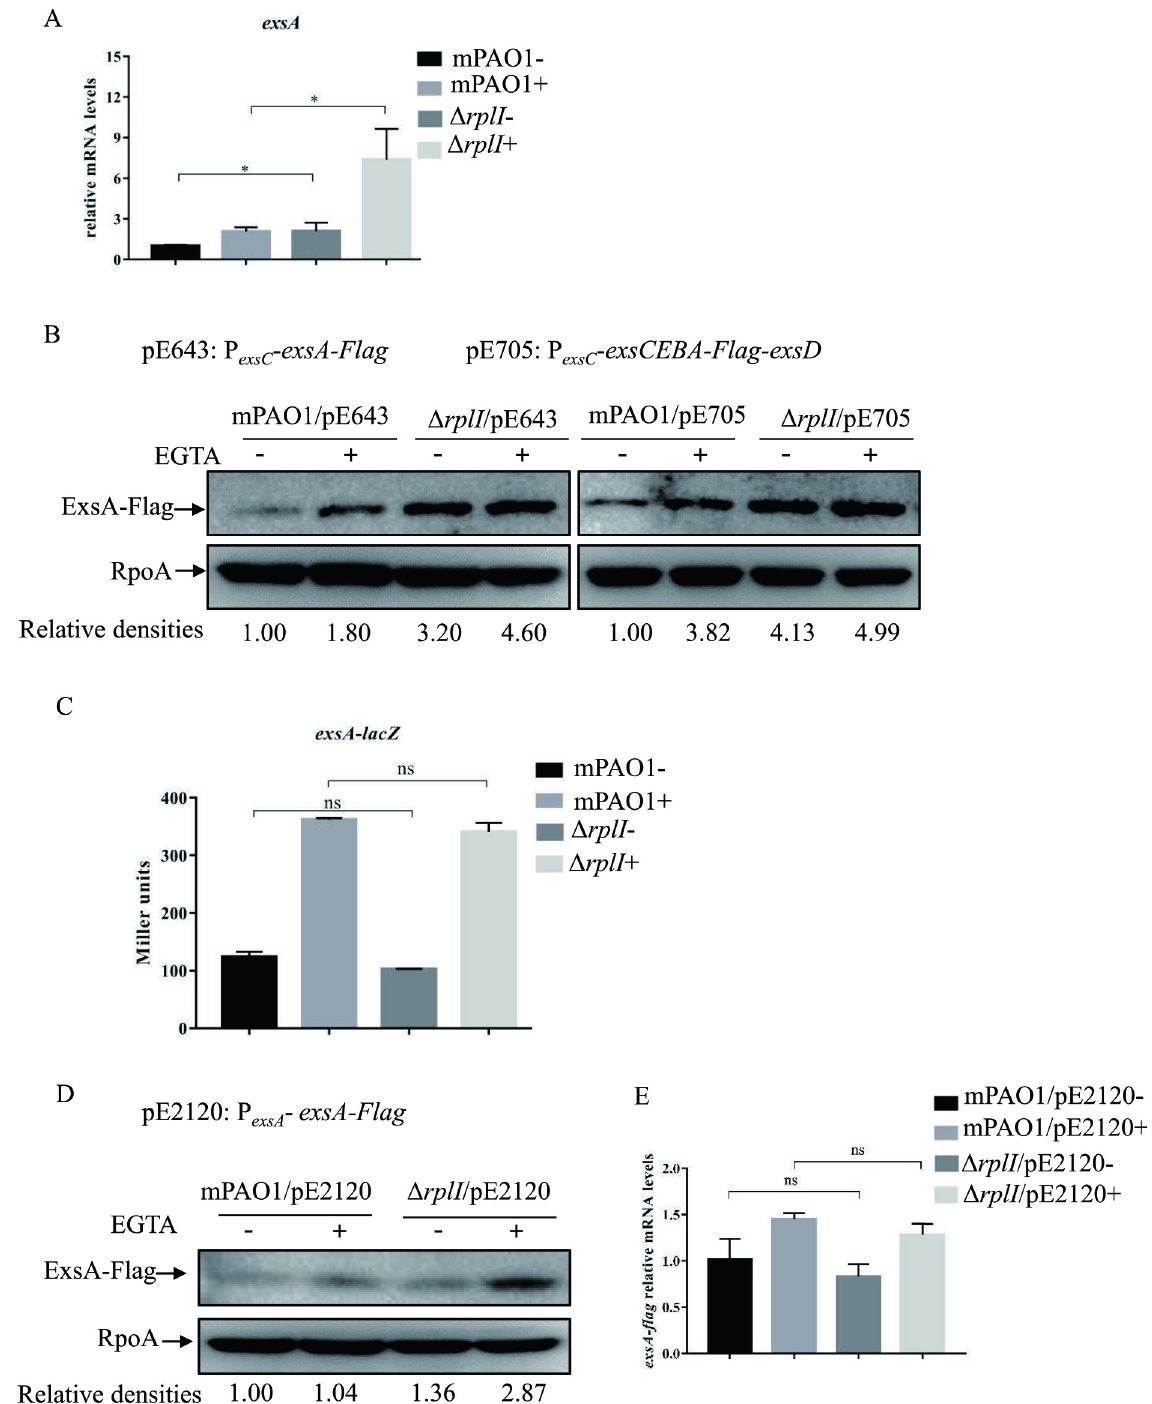
Fig 2. Role of RplI in the expression of ExsA. (A and E) The relative exsA (A) or exsA-flag (E) mRNA levels in mPAO1 and Δ rplI containing pE2120 (E) or not (A). Total RNA was isolated under T3SS inducing (+) and non-inducing (-) conditions with 5 mM EGTA and the exsA or exsA-flag mRNA levels were determined by real-time qPCR using rpsL as the internal control. ns, not significant, � P < 0.05, by Student’s t test. (B and D) Amounts of ExsA-Flag. mPAO1 and Δ rplI containing pE643 or pE705 integrated into the chromosome or pE2120 were grown to an OD 600 of 1.0 in LB with (+) or without (-) 5 mM EGTA and collected by centrifugation. Samples from equivalent numbers of bacterial cells were separated by SDS-PAGE and probed with an anti-Flag or an anti-RpoA antibody. The density of each band was determined with Image J. Relative densities represent the density of ExsA-Flag/density of RpoA with the respective first lane as 1. The data shown represent the results